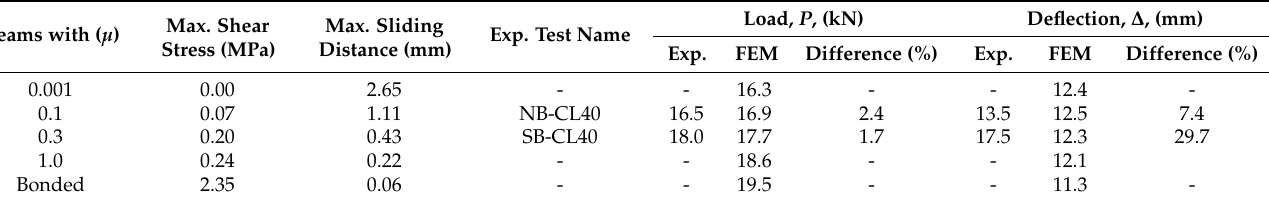
Table 6. Load and deflections of the GFRP box beam with FE Model Analysis.